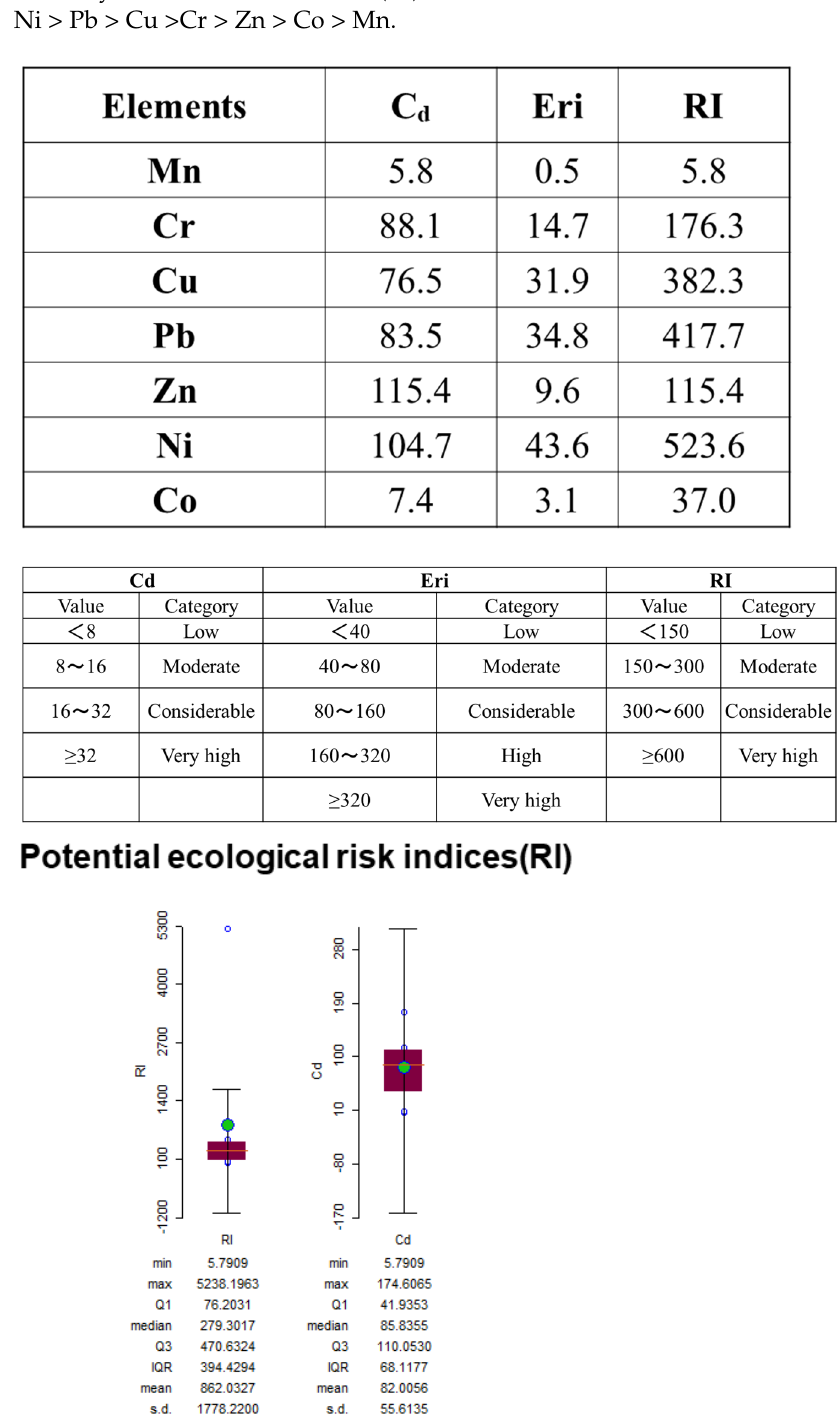
Figure 7. The pollution indices of the AC filter particulate matter samples around the study area.